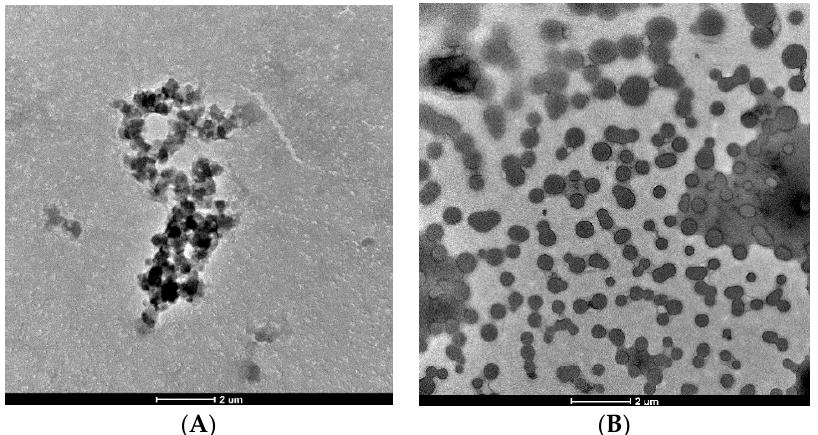
Figure 5. Transmission electron microscopy (TEM) of the POSS:DOX ( A ) and POSS:DAU ( B ) complexes after a 3-h incubation. Abbreviations: DAU, daunorubicin; DOX, doxorubicin; POSS, polyhedral oligomeric silsesquioxanes.